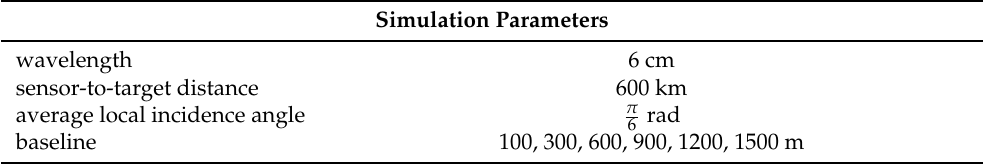
Table 2. Values of parameters used for the simulation of synthetic phase